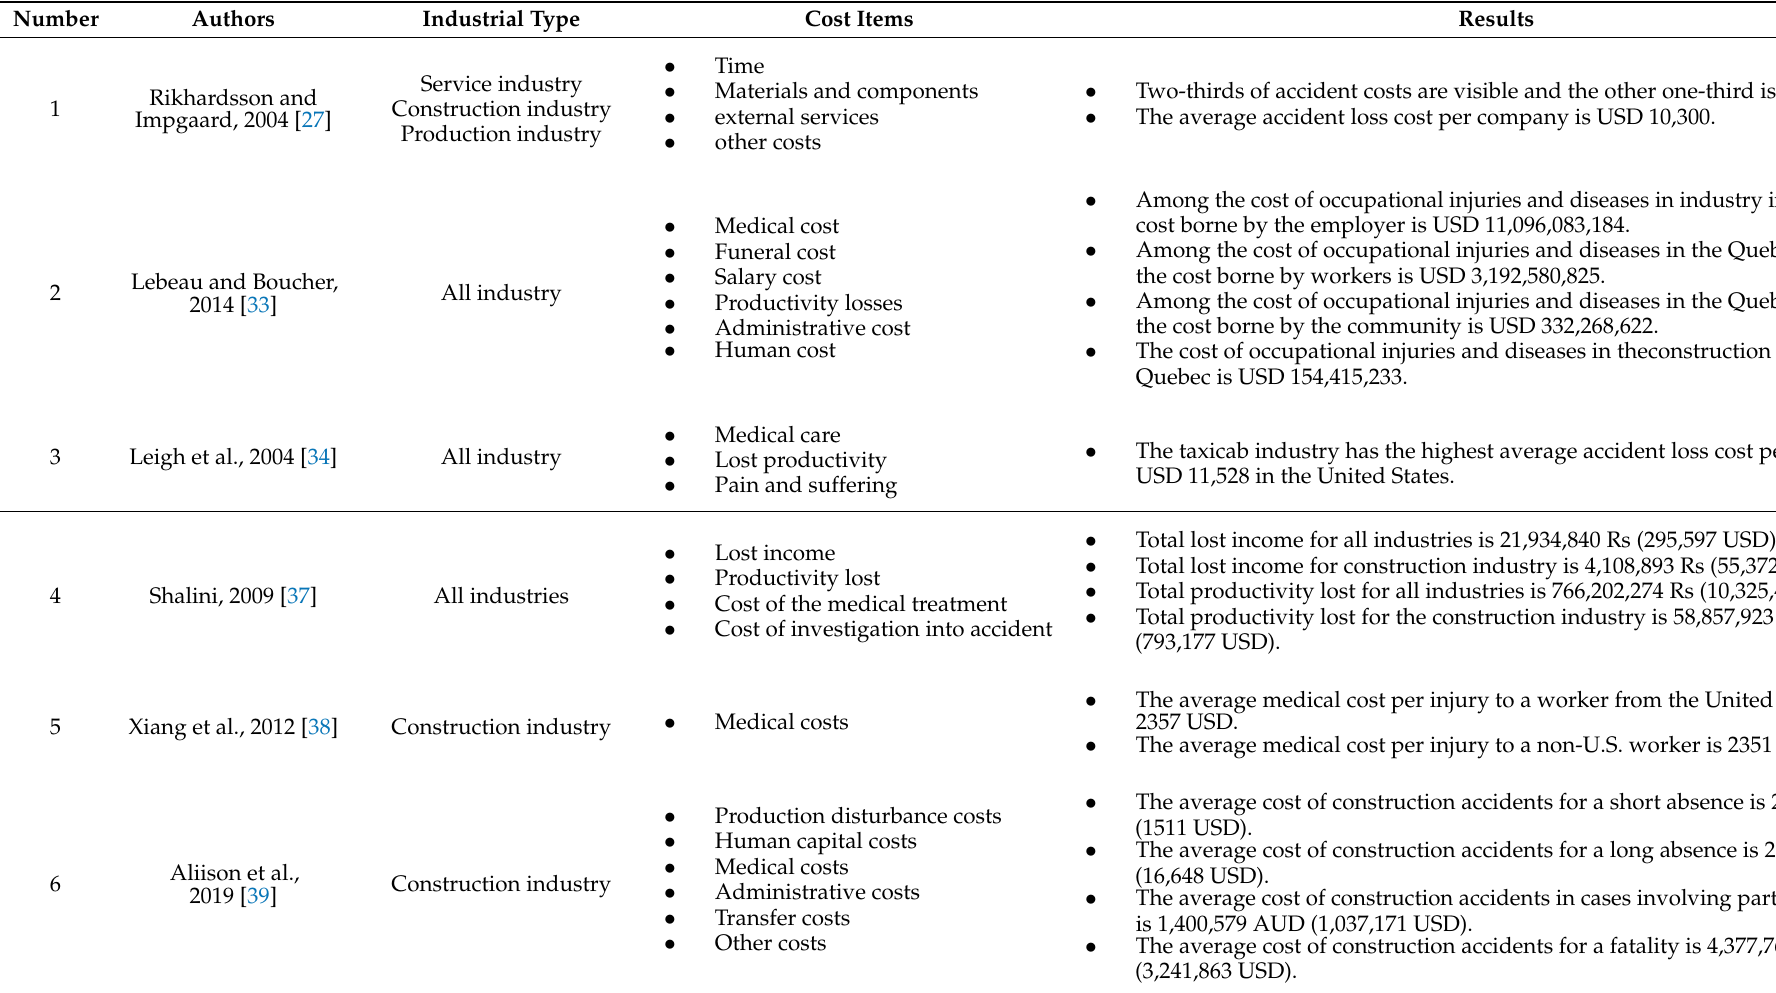
Table 1. Results of the literature